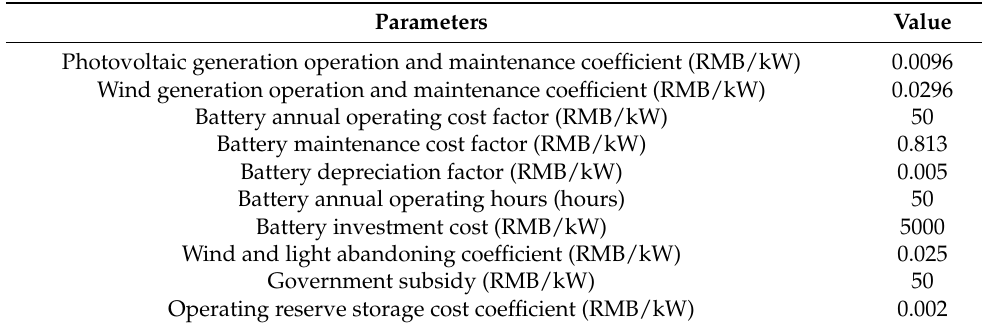
Table 6. Equivalence coefficient.